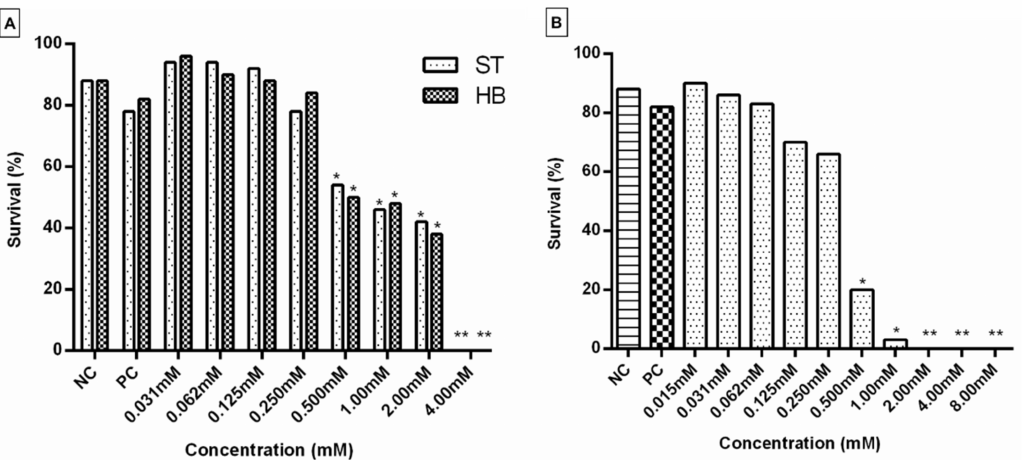
Figure 3. Survival rate of D. melanogaster obtained from the Toxicity Test (TX) of different concentra- tions of complex 1 . ( A ) Lineages of the Standard (ST) Cross and High-Bioactivation (HB) Cross used in the SMART test; ( B ) lineages used in the ETT test. * p < 0.05 and ** p <